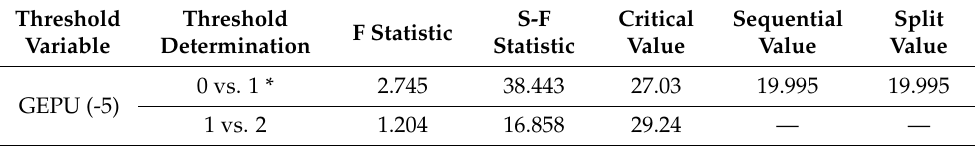
Table 3. Soybean price threshold quantity determination results.